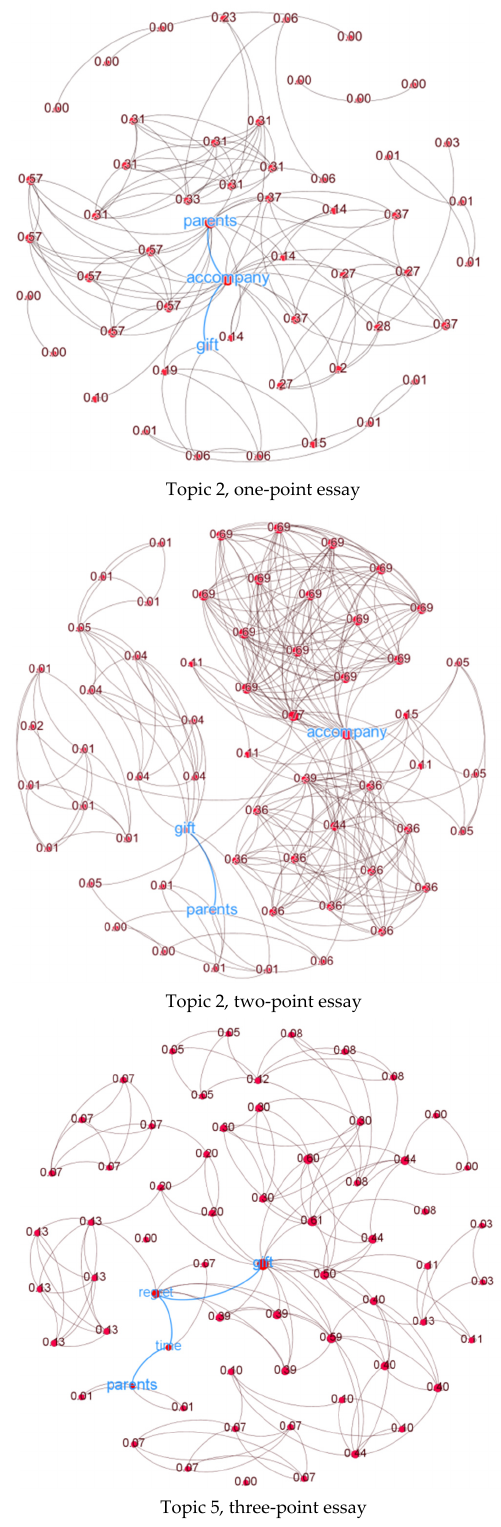
Figure 5. Examples of individual semantic networks for one-point, two-point, and three-point essays. The nodes represent single words and are labeled as numbers (normalization of Logevcnmean); the larger the node size, the higher the centrality. The gray lines represent the edges connecting the nodes.